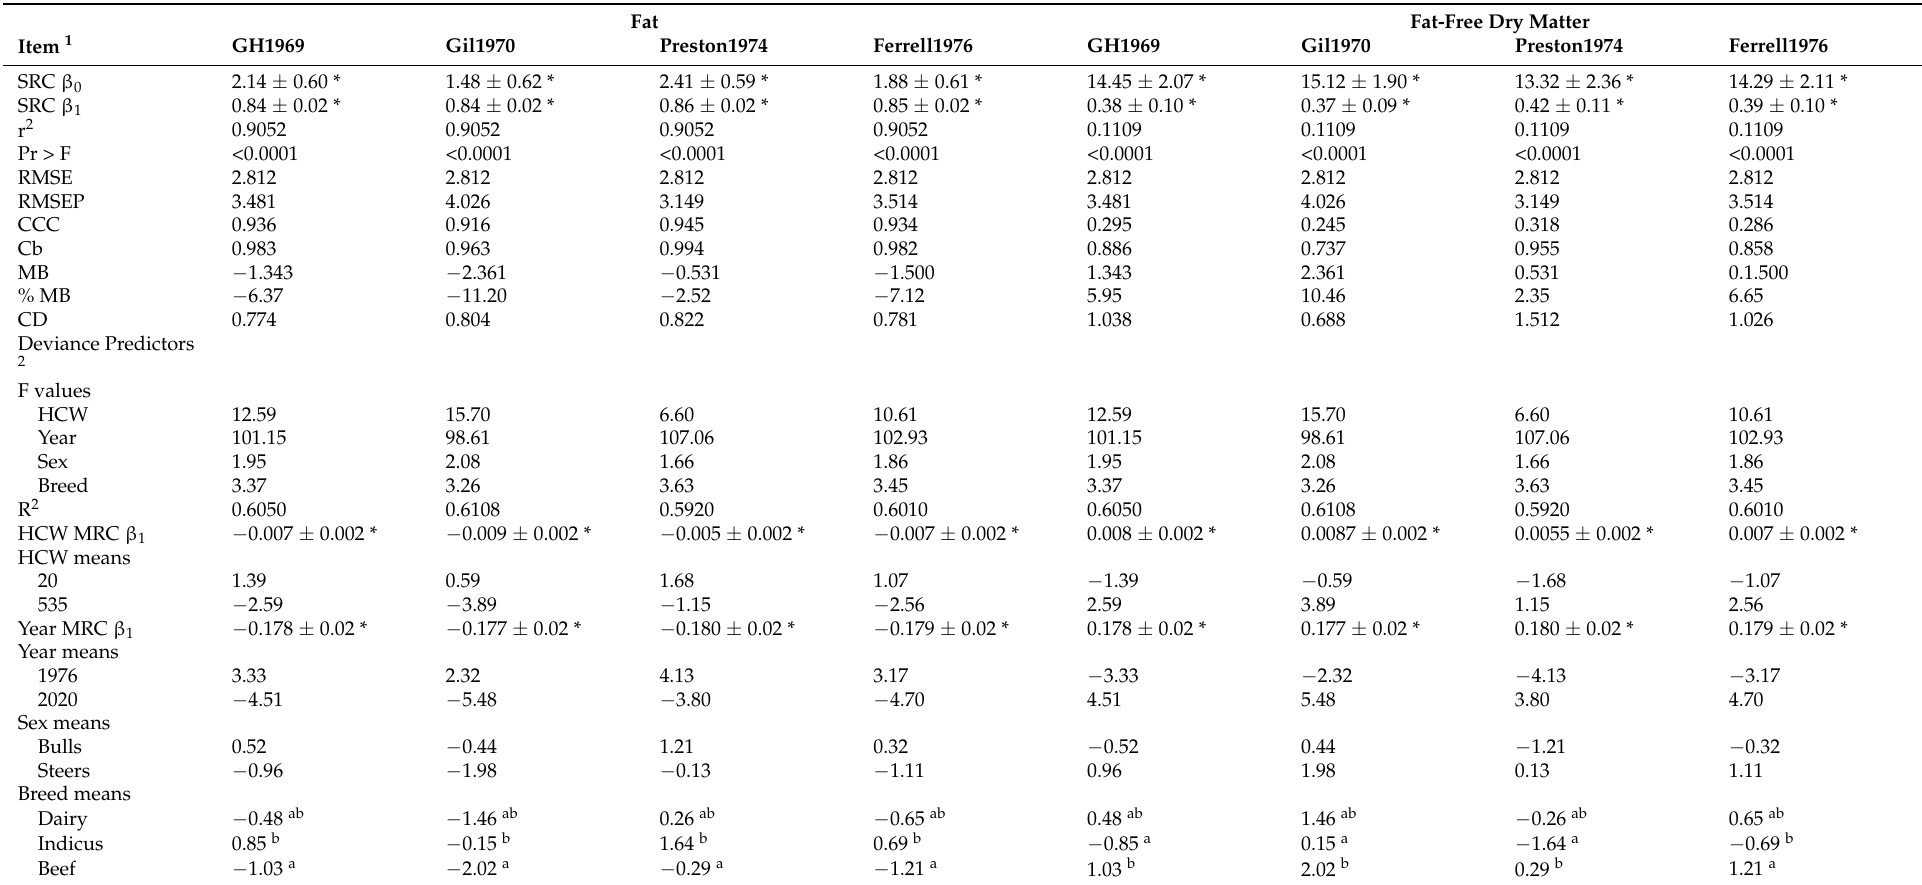
Table 9. Model evaluation of predicting carcass chemical fat and fat-free dry matter assuming carcass water is known, and predictive variables of the deviance between observed and predicted carcass chemical components in the Carcass